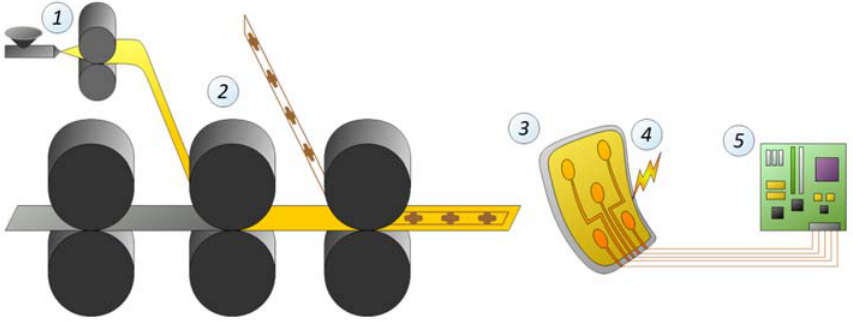
Figure 1. Process chain for mass production ‐ enabled manufacturing of hybrid laminates: ① Foil extrusion, ② Joining, ③ Forming, ④ Polarization, ⑤ Signal Processing.